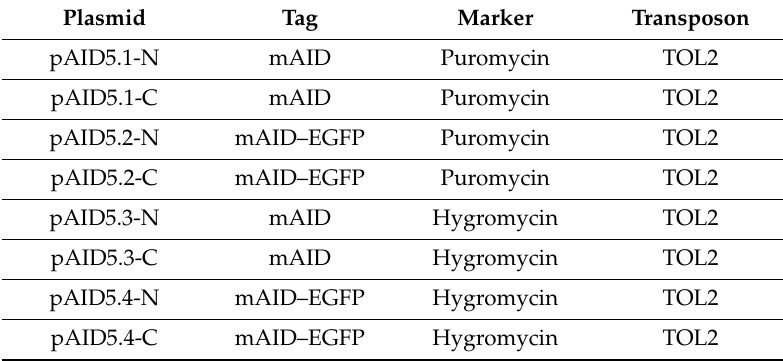
Table 1. It shows the features of pAID5